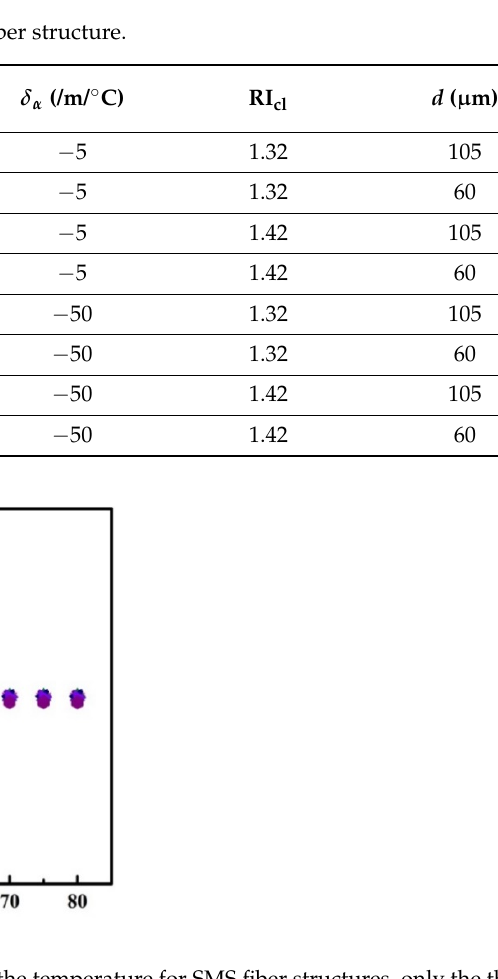
Figure 9. Dip Wavelength as a function of the temperature for SMS fiber structures, only the thermal effect of absorption characteristic is taken into account in the simulation.